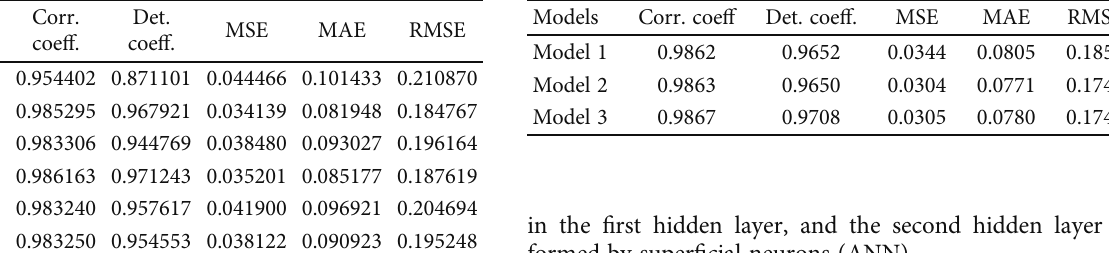
Table 5: Evaluation of the